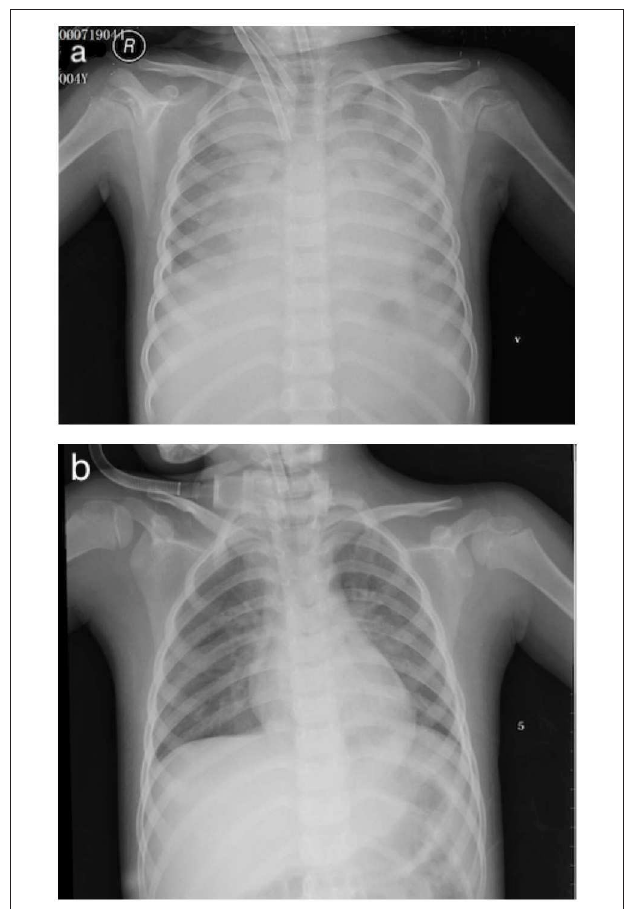
FIGURE 2 | (a) V-A ECMO via neck cannulation with a 15-Fr cannula in the right atrium and a 12-Fr cannula in the right common carotid aorta. (b) Chest X-ray post-ECMO.